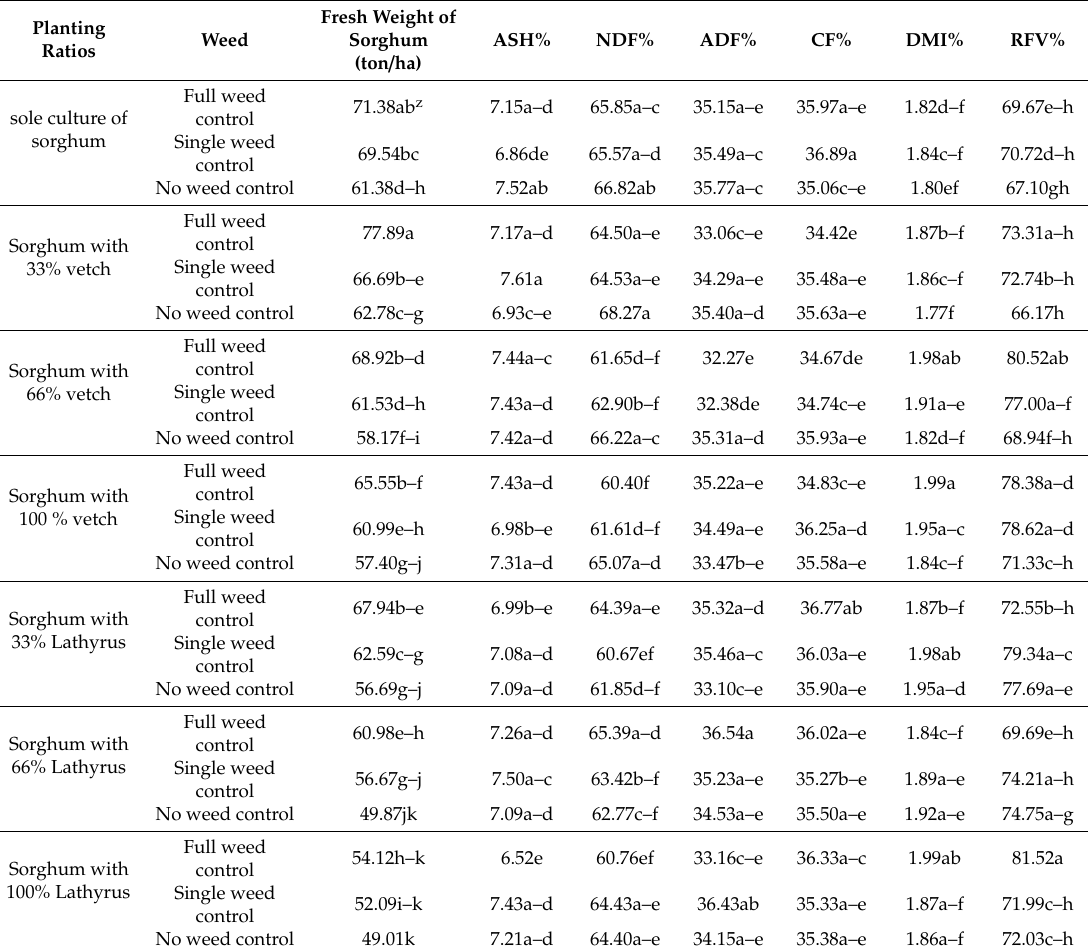
Table 5. Interaction e ff ects of intercropping and weed management on quantitative and qualitative traits of